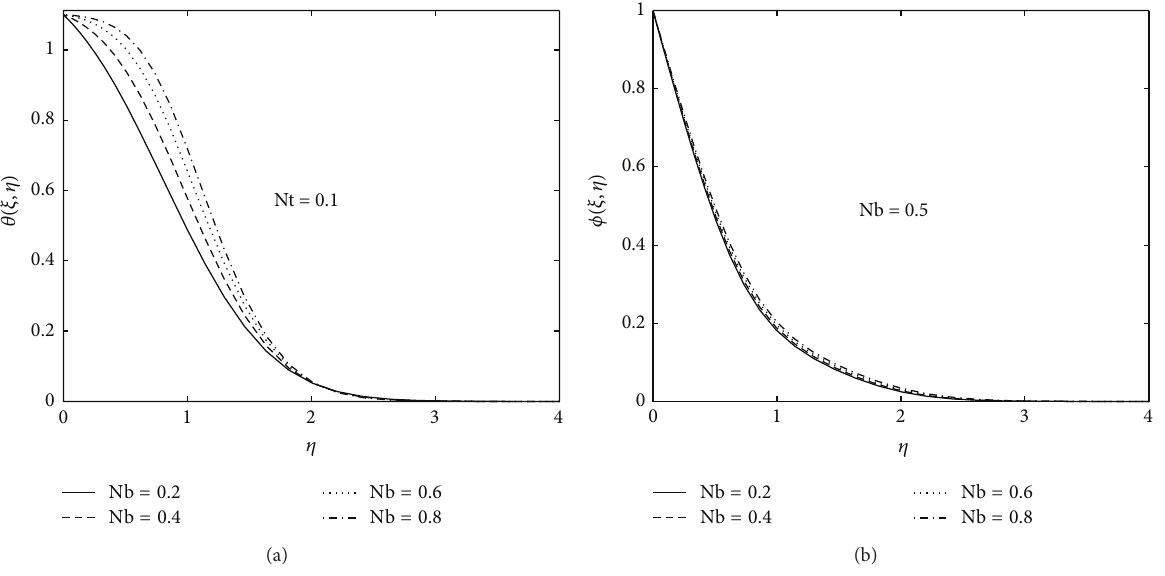
Figure 6: Effect of the Nb on 𝜃(𝜂) and 𝜙(𝜂) for 𝜉 = 0.5 , Le = 10 , Pr = 7 , 𝜎 = 0.3 , Nr = 0.1 , Nt = 0.1 , and 𝐴 = 0.1